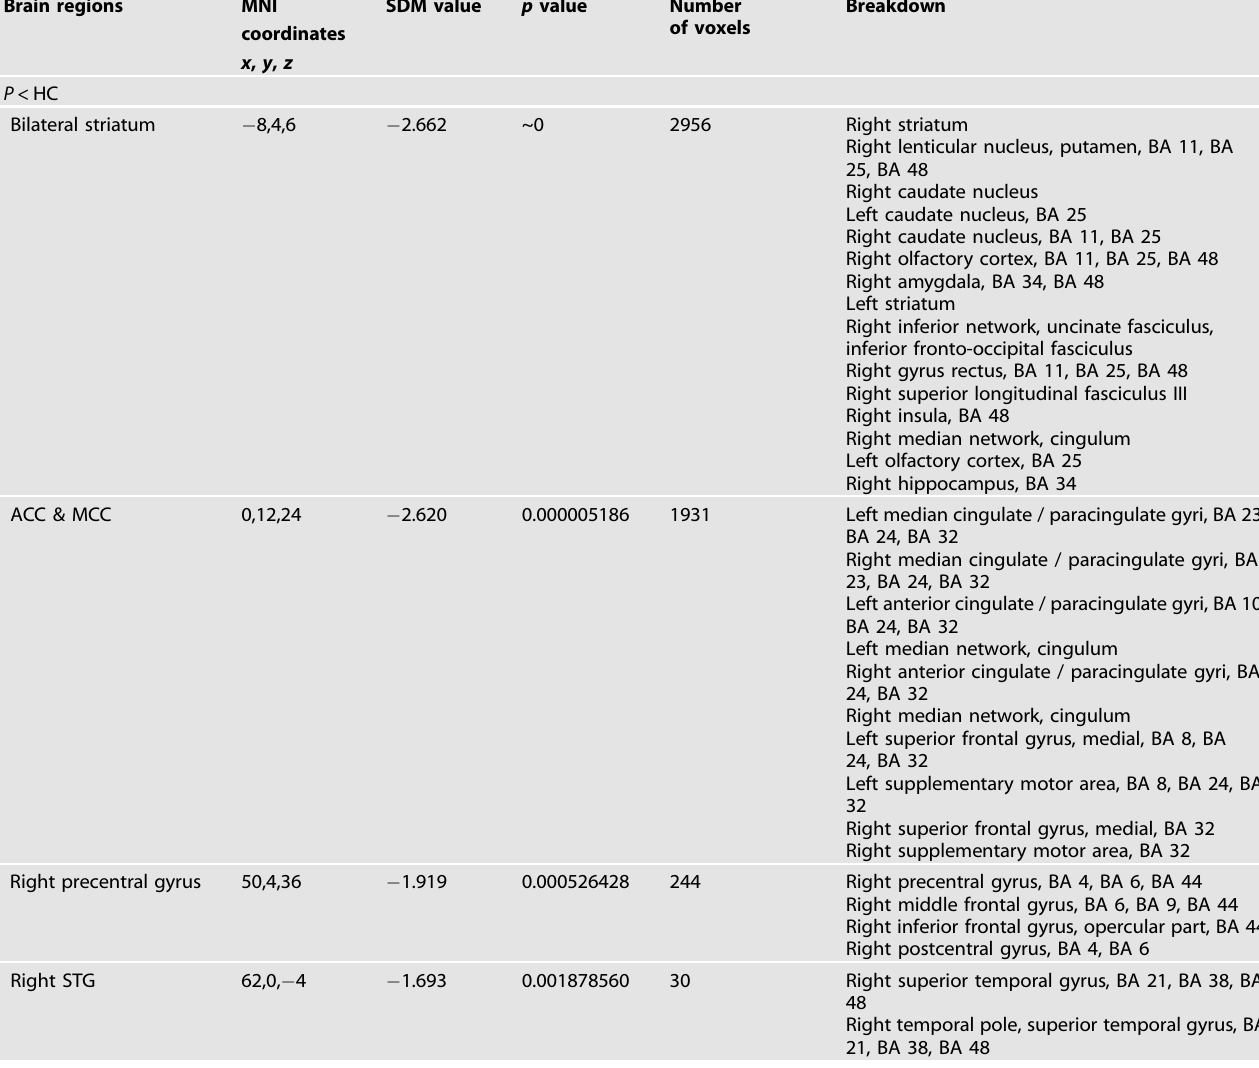
Table 2. Results of the meta-analysis for brain activation difference between SZ and HC during reward anticipation